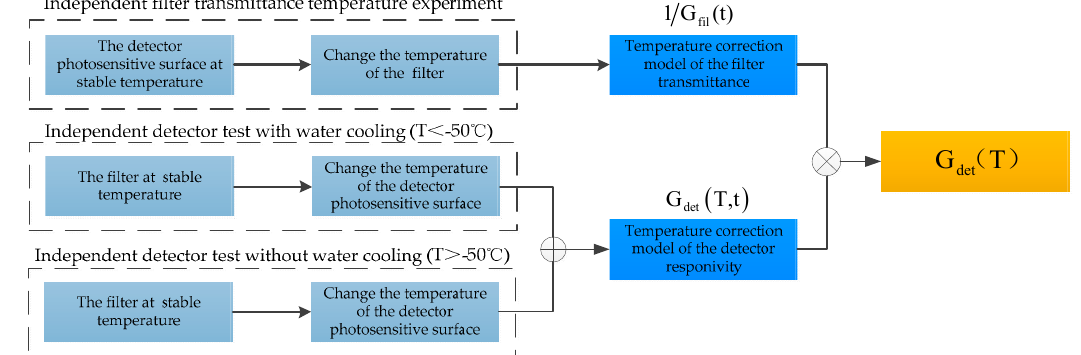
Figure 7. Schematic diagram of the detector-level RTDC experimental method.